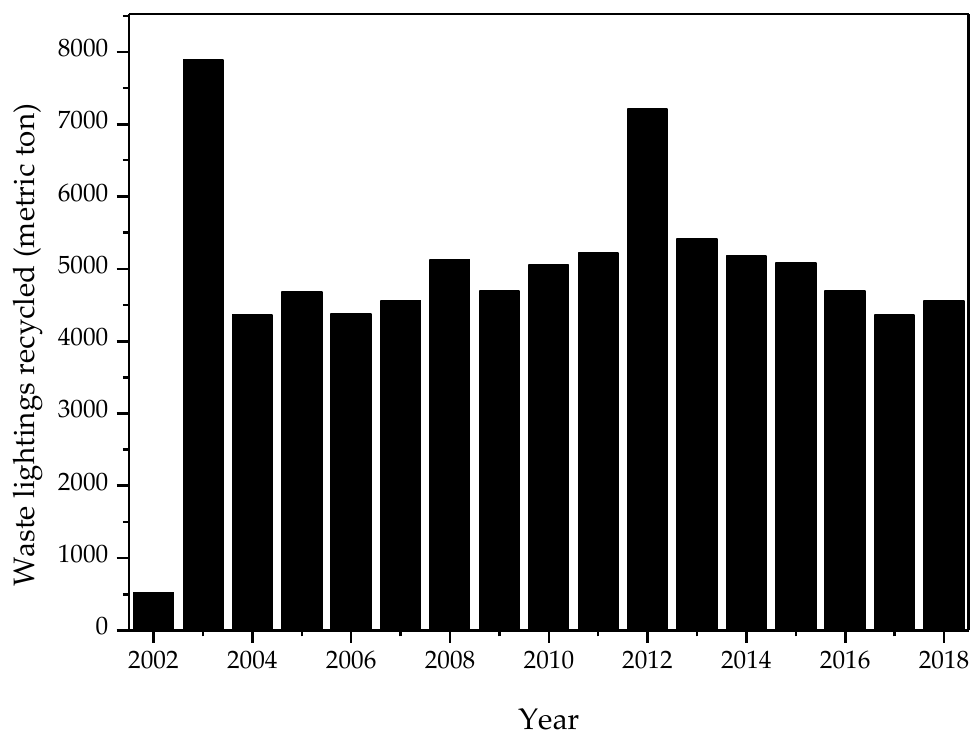
Figure 2. Amount of waste lighting recycled during 2003–2018 in Taiwan [39]. Table 6. Implementation date that lighting was listed as one of mandatory recyclables in Taiwan.